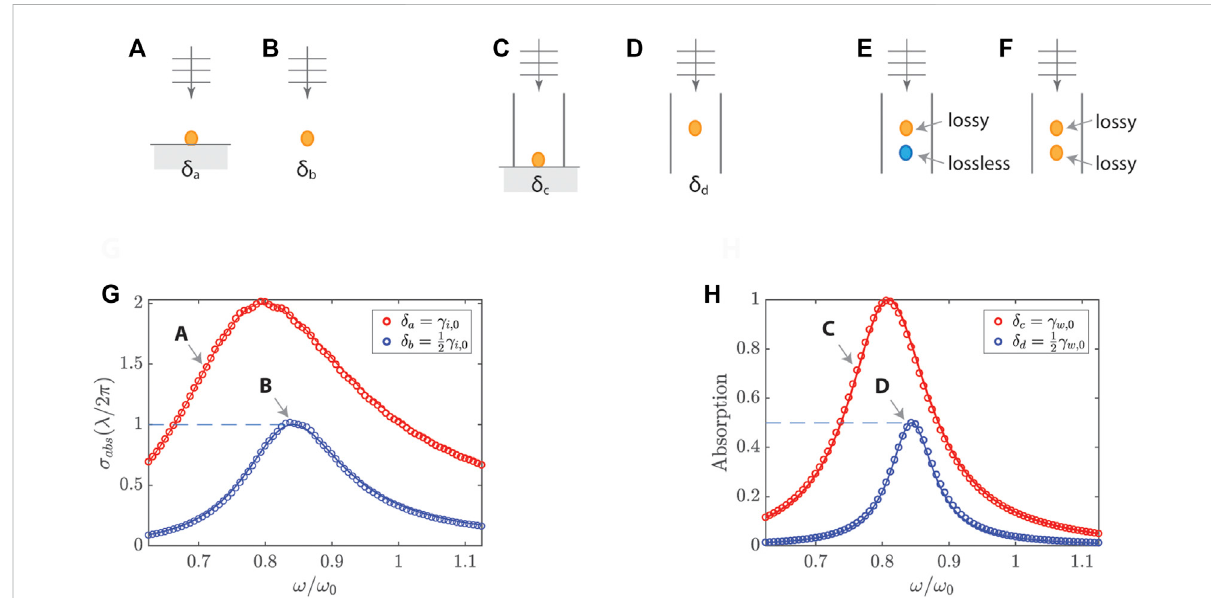
FIGURE 5 Critical coupling for acoustic absorption. Single resonators in a free fi eld with a backing surface (A) and free fi eld (B) . Single resonators in waveguides for one-port (C) and two-port systems (D) . Dual resonators in a waveguide for loss/lossless (E) and loss/loss (F) . (G) Absorption cross section spectra for (A) and (B) . (H) Absorption spectra for (C) and (D) . Adapt (G) from Ref. [36]; Adapt (H) from Ref.